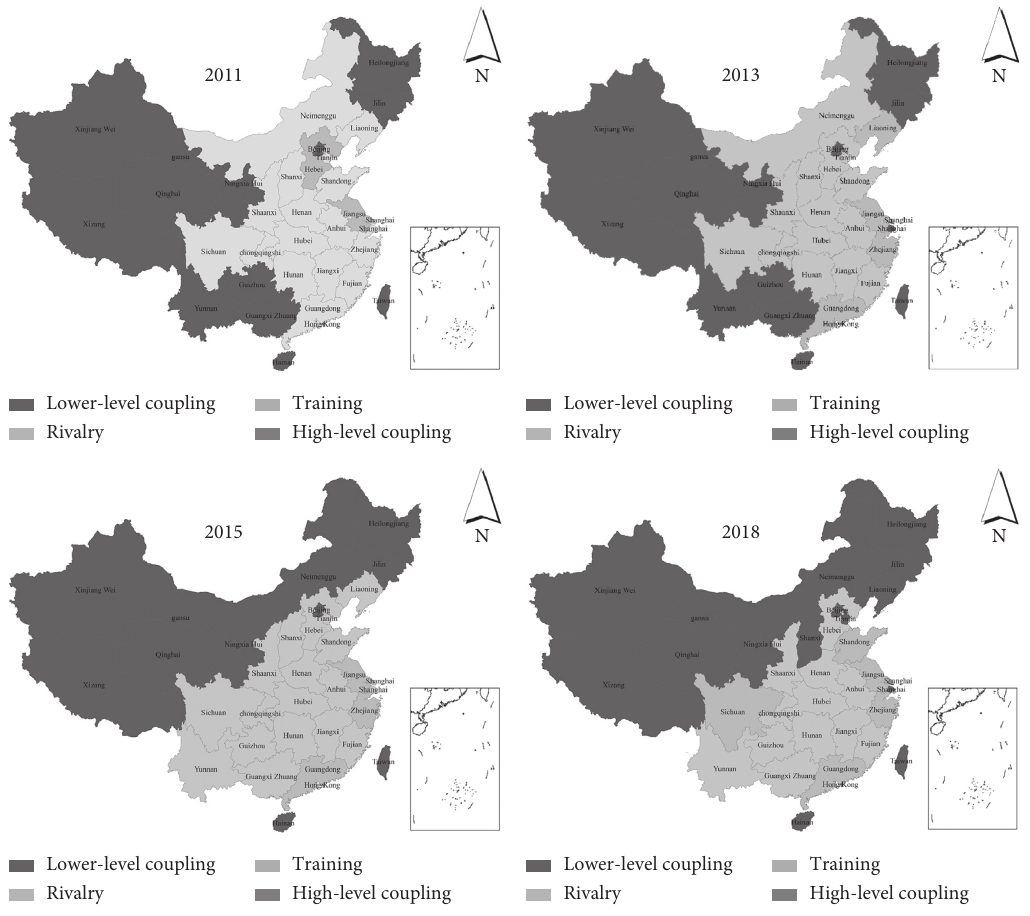
Figure 7: Distribution of coupling